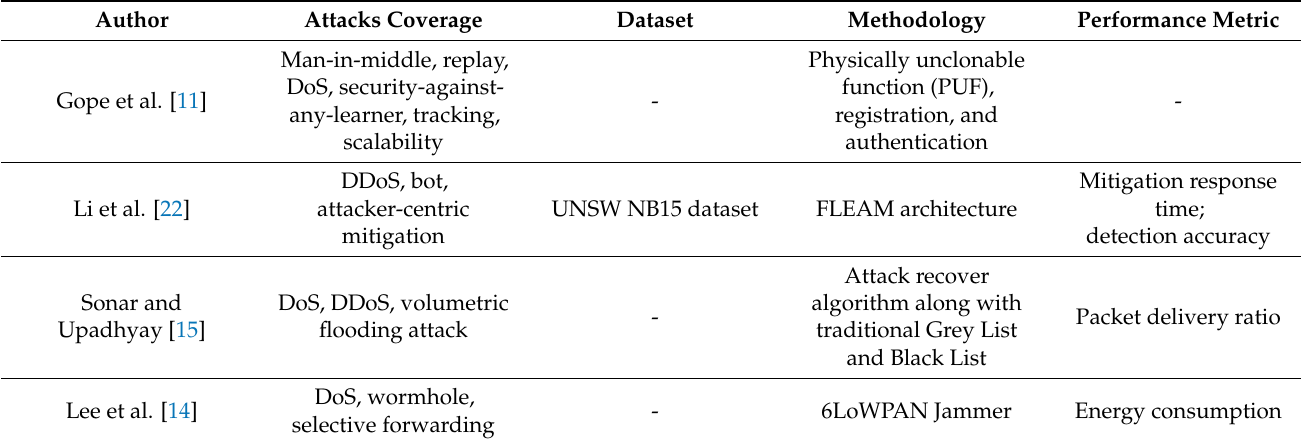
Table 2. Summary of some important previously proposed